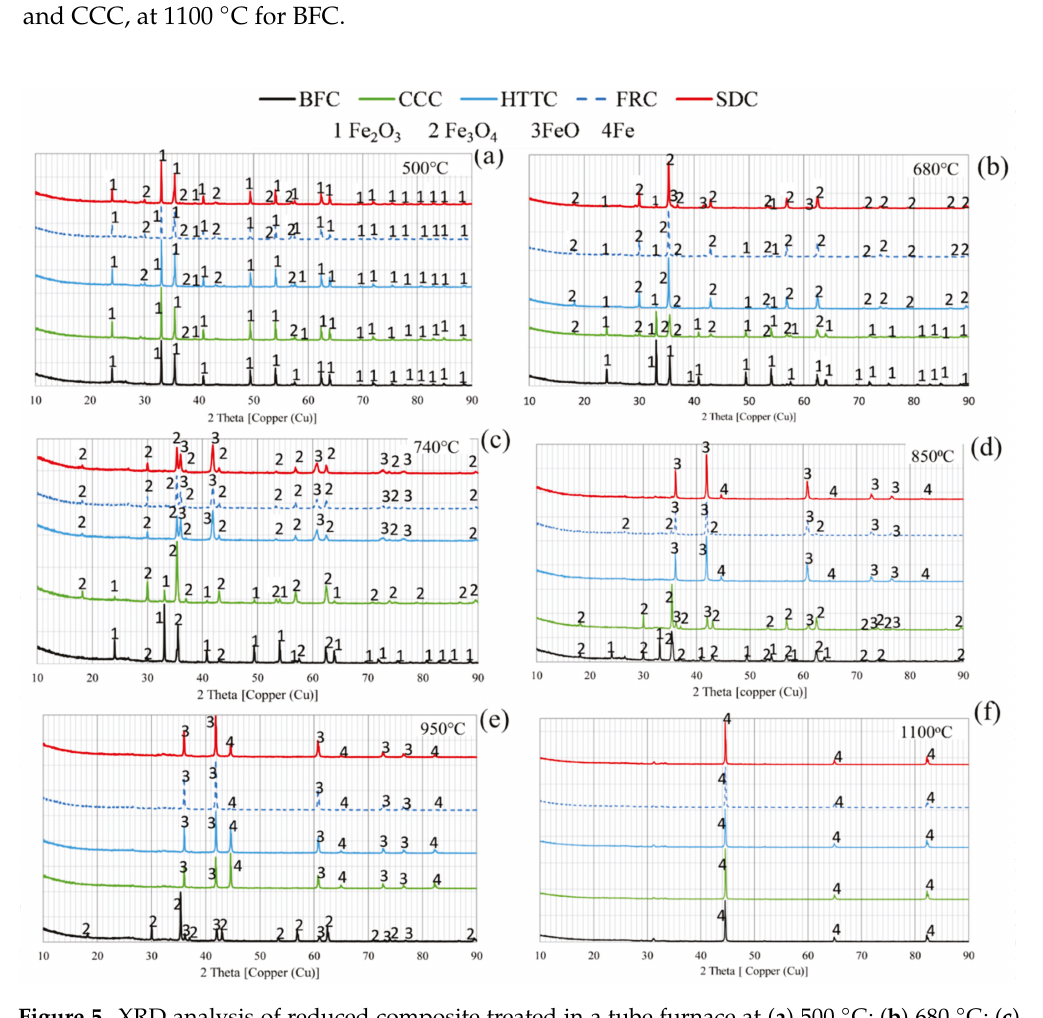
Figure 5. XRD analysis of reduced composite treated in a tube furnace at ( a ) 500 ◦ C; ( b ) 680 ◦ C; ( c ) 740 ◦ C; ( d ) 850 ◦ C; ( e ) 950 ◦ C and ( f ) final sample up to 1100 ◦ C in